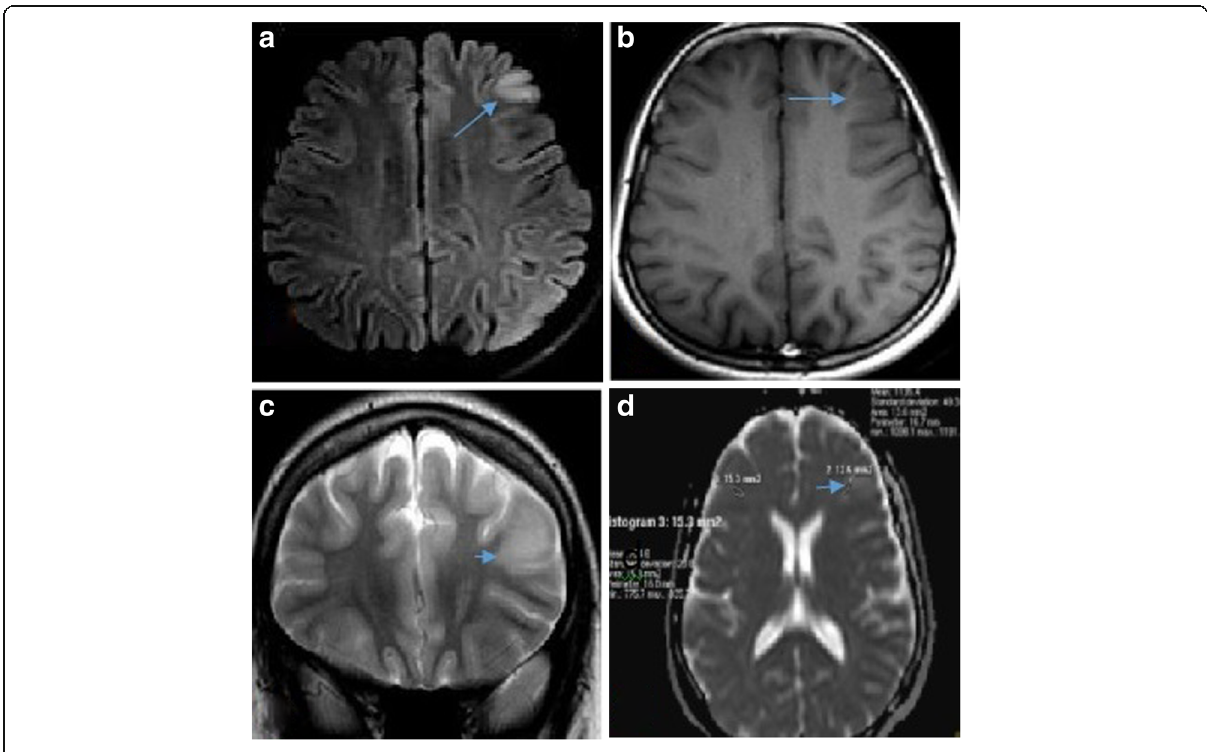
Fig. 1 A 48-year-old male patient with epilepsy. a Increase in cortical signal intensity in axial FLAIR sequence-subcortical signal intensity. b Cortical thickening in axial T1A sequence. c Cortical signal intensity in coronal T2A sequence, blurring in white-gray matter interface. d Hyperintense area in axial dADC sequence, ADC measurement from this area and from a symmetrical